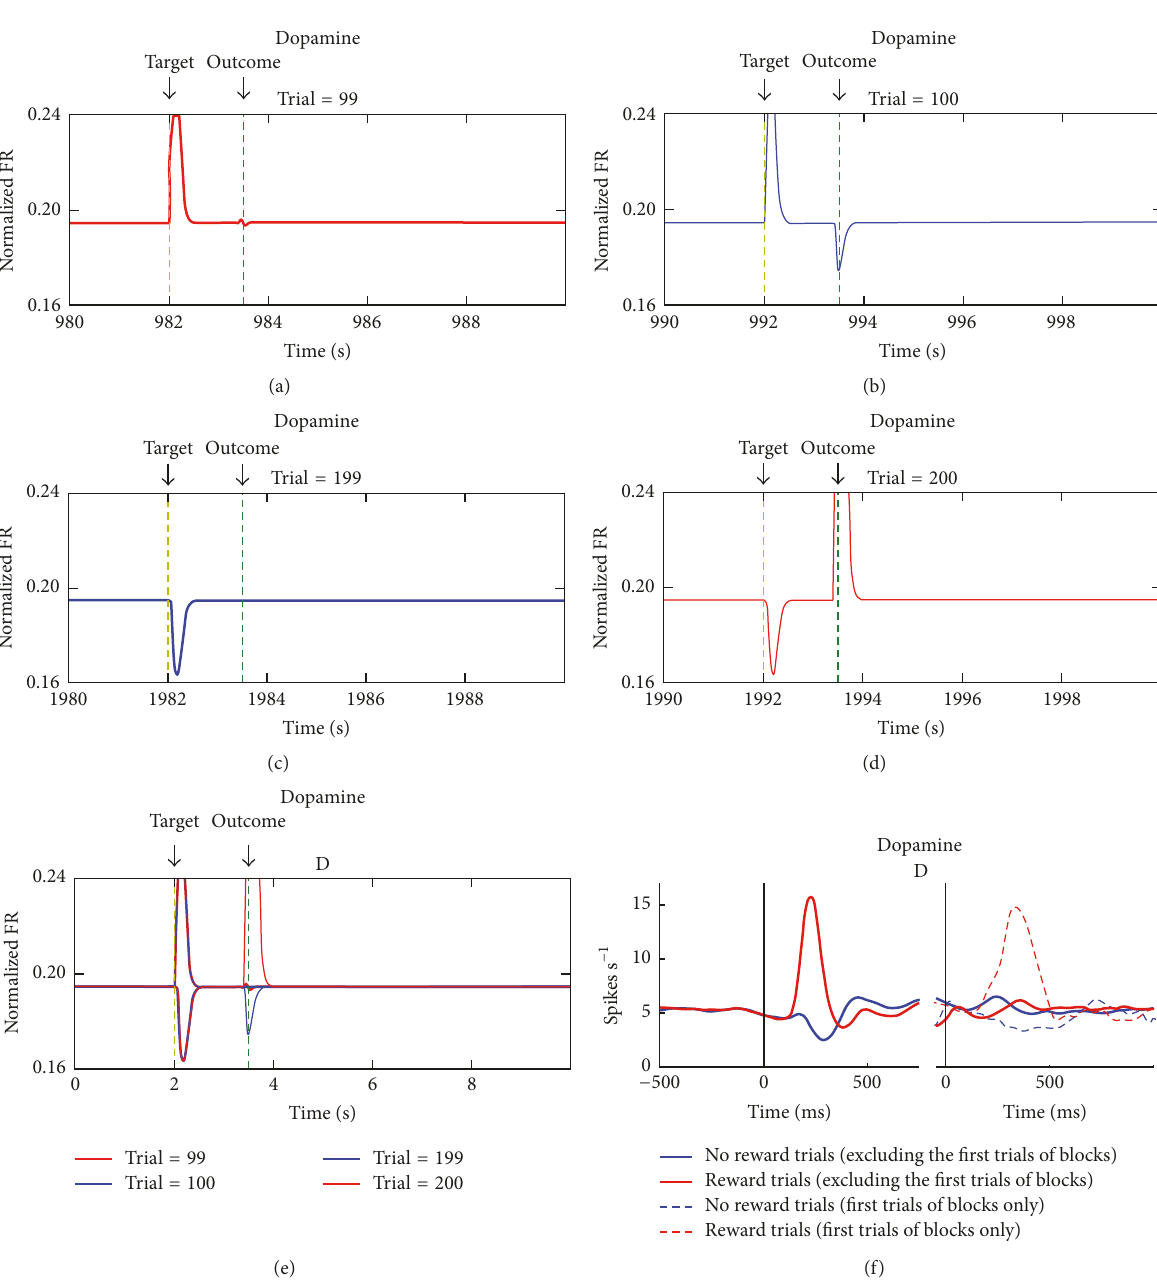
Figure 5: Acquired response of DA neurons. (a) The 99th trial: from the 1st to 99th trials, the model circuit receives a rewarding CS and a rewarding US. The result shows that, after learning, DA neurons exhibit a phasic peak upon rewarding CS and a baseline in response to reward outcome. (b) The 100th trial: the model circuit receives rewarding CS and nonrewarding US. The result shows that DA neurons exhibit a phasic peak when rewarding CS appears and exhibit a phasic dip at the time when the reward is expected. (c) The 199th trial: from the 101st to 199th trials, the model circuit receives nonrewarding CS and a nonrewarding US. The result shows that, after learning, the DA neurons exhibit a phasic dip upon nonrewarding CS and a baseline when there is no reward released at this trial. (d) The 200th trial: the model circuit receives nonrewarding CS and rewarding US. The result shows that DA neurons exhibit a phasic dip when nonreward CS appears and exhibit a phasic peak upon reward US. (e) The phasic activity of DA neurons under different situations. The thick red line indicates the activity of DA neurons at the 99th trial, the narrow blue line indicates the activity of DA at the 100th trial, the thick blue line indicates the activity of DA neurons at the 199th trial, and the narrow red line indicates the activity of DA neurons at the 200th trial. The yellow dashed line indicates the time at which CS appears and the green dashed line indicates the time at which rewards are released or not. (f) The physiological experimental result reprinted from Matsumoto and Hikosaka [5]. Red lines indicate reward trials, and blue lines indicate no reward trials. Full lines indicate reward CS-to-reward US (red) and nonreward CS-to-nonreward US (blue), while dashed lines indicate reward CS-to-nonreward US (blue) and nonreward CS-to-reward US